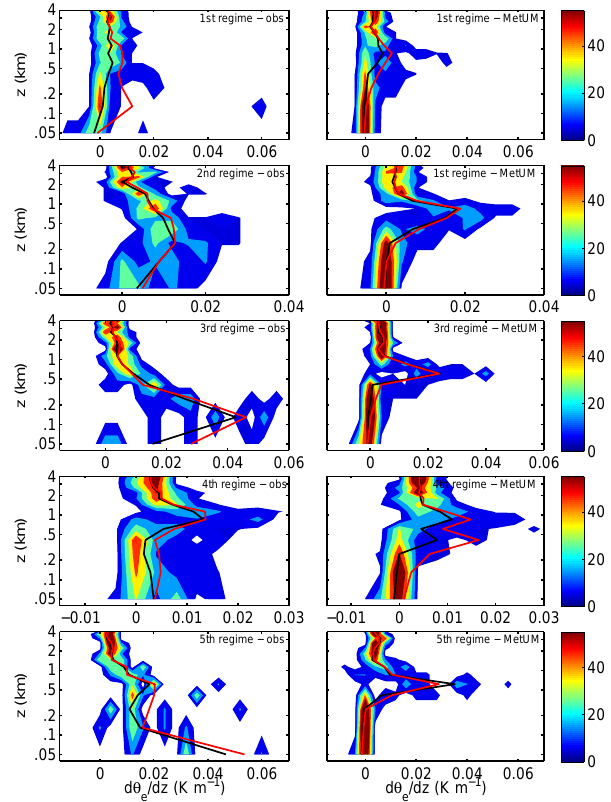
Fig. 4. Contours of the probability of static stability, given by the vertical derivative of equivalent potential temperature ( ∂θ e / ∂z ), as a function of height. Observations are from the 6-hourly soundings and the model data are from 3-hourly diagnostics. The red and black lines are the mean and median static stability at each vertical level respectively. Note the logarithmic height scale and the change in scale on the